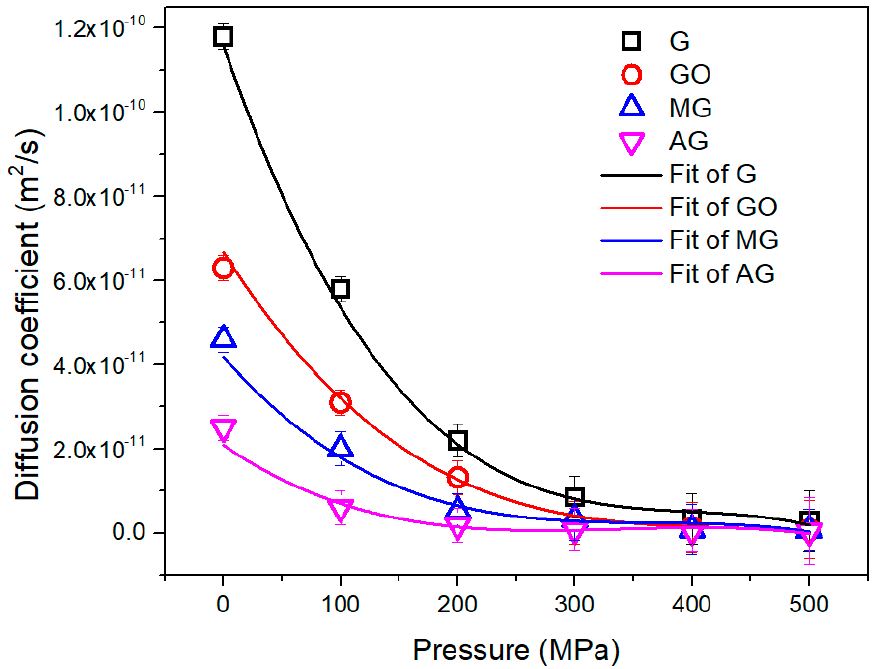
Figure 10. Diffusion coefficients of graphene containing two functional groups with respect to increasing pressures at 300 K.